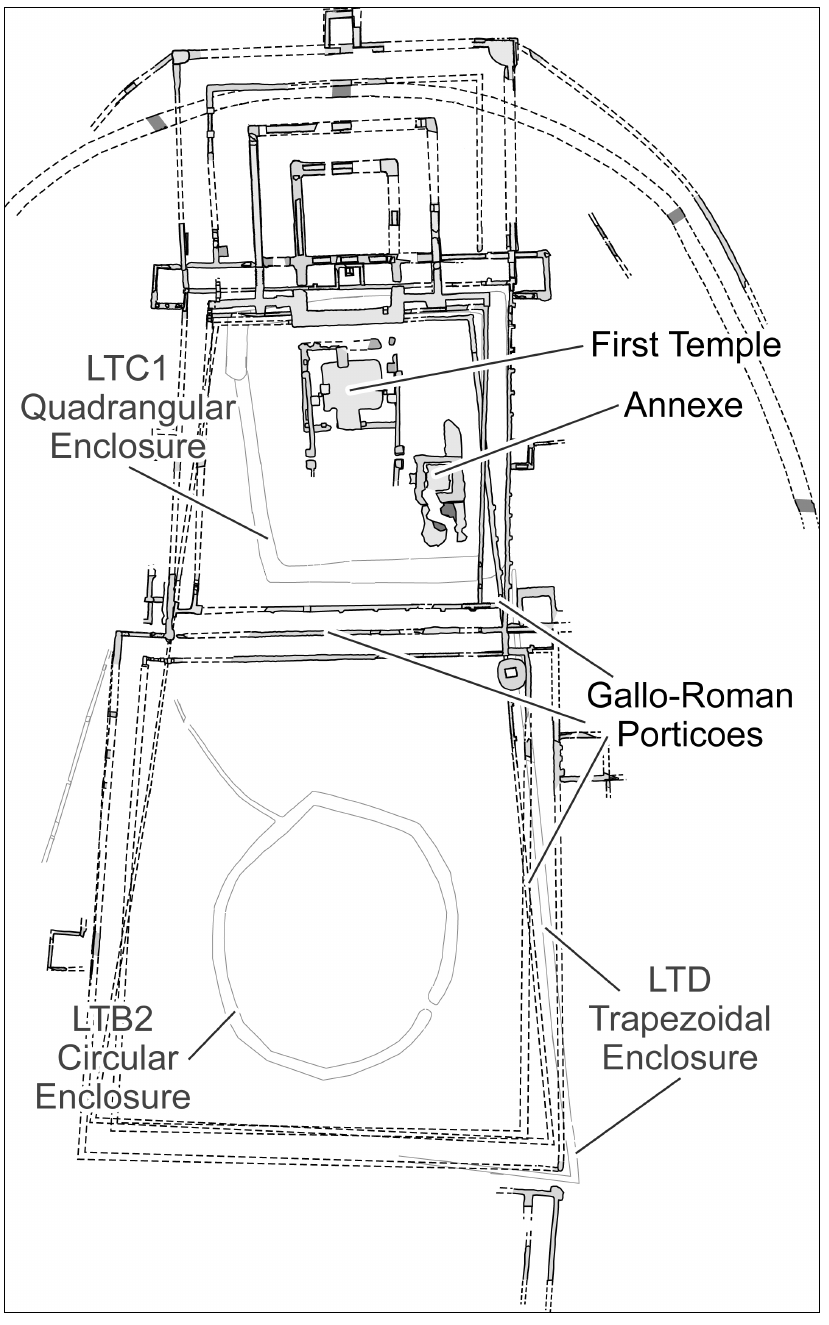
Figure 4: The La Tène and Roman enclosures at Ribemont (illustration: G. Fercoq du Leslay, Conseil Départemental de la